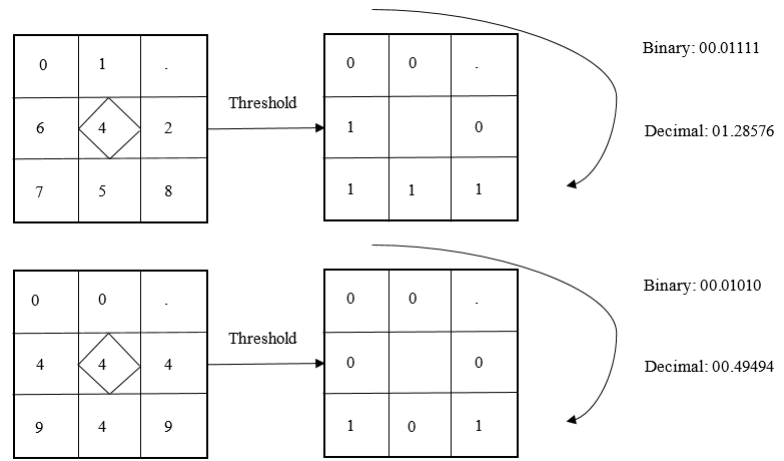
Figure 5. Improvements to shape-indexed face features.